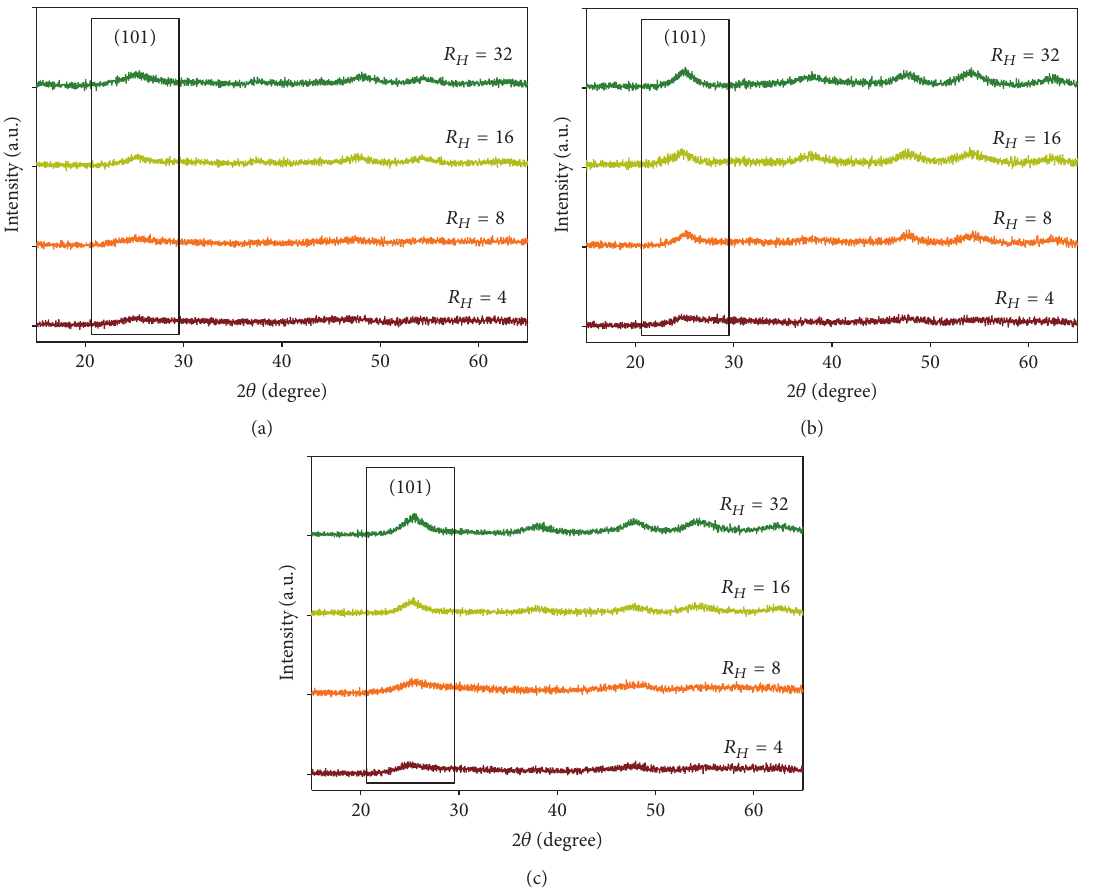
Figure 3: XRD diffraction patterns: (a) HCl-THF/TiO 2 , (b) HNO 3 -THF/TiO 2 , and (c) ClHNO 2 -THF/TiO 2